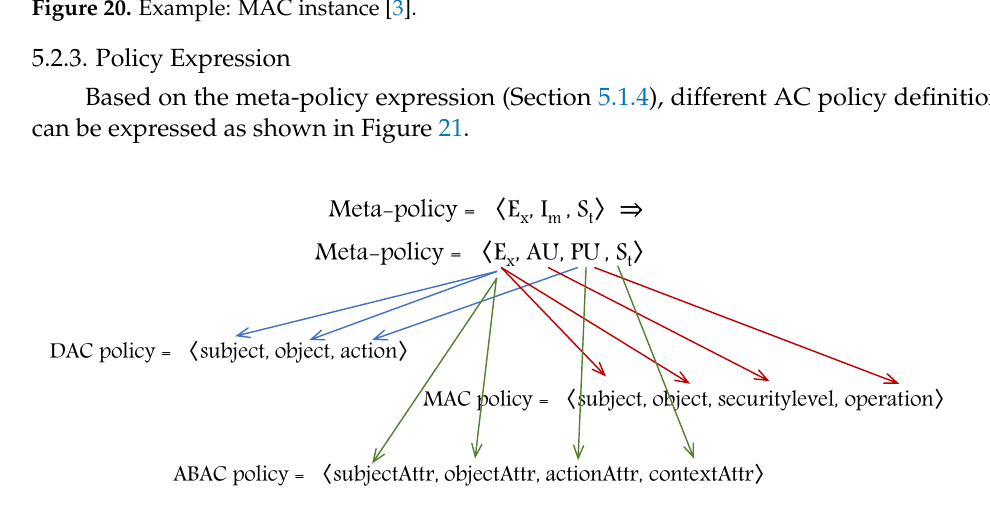
Figure 21. Examples of policy expressions using the meta-policy of HEAD